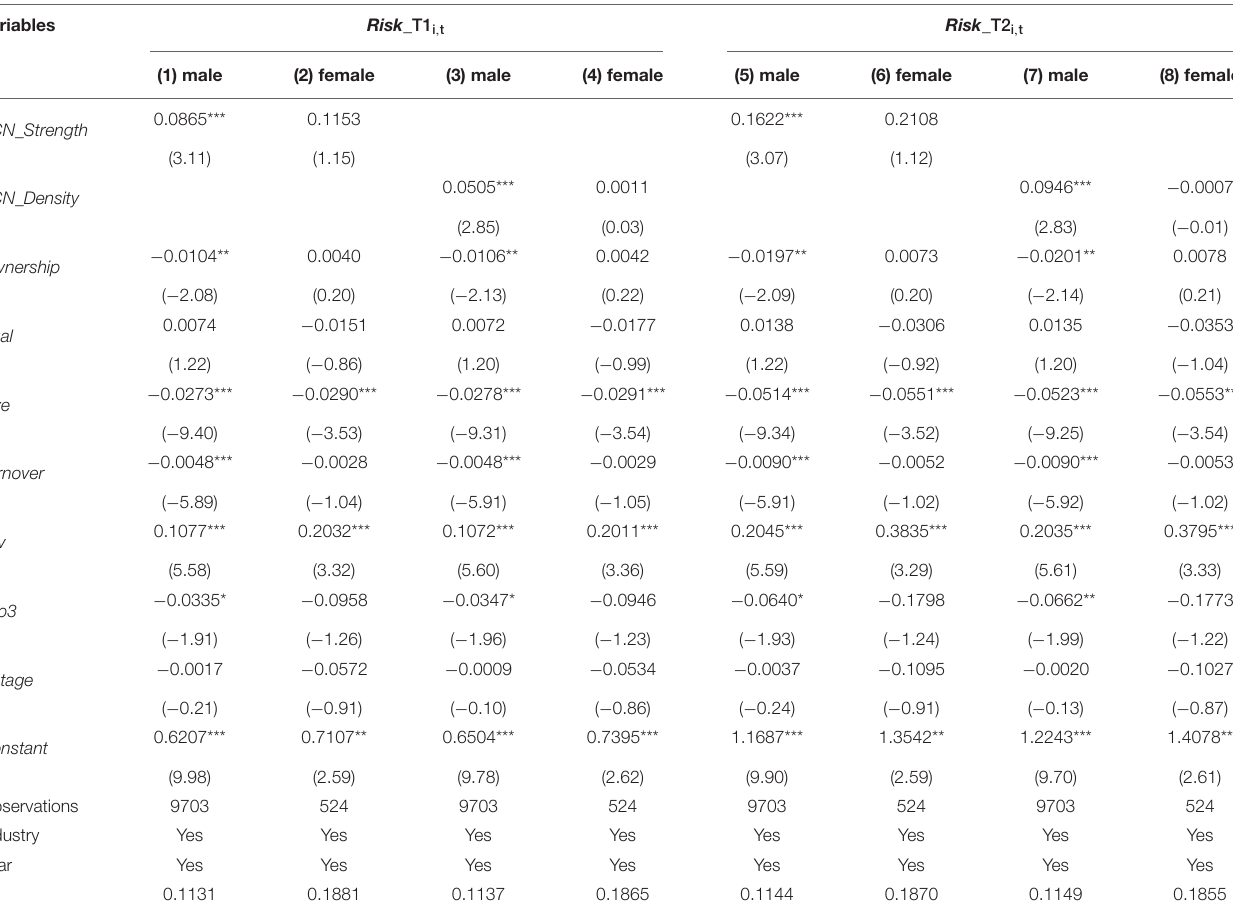
TABLE 7 | Results of male managers and female managers.